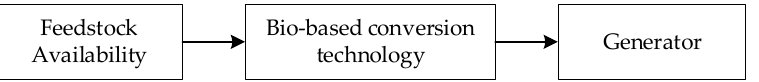
Figure 12. Feedstock availability and operation models for bio-based generation.